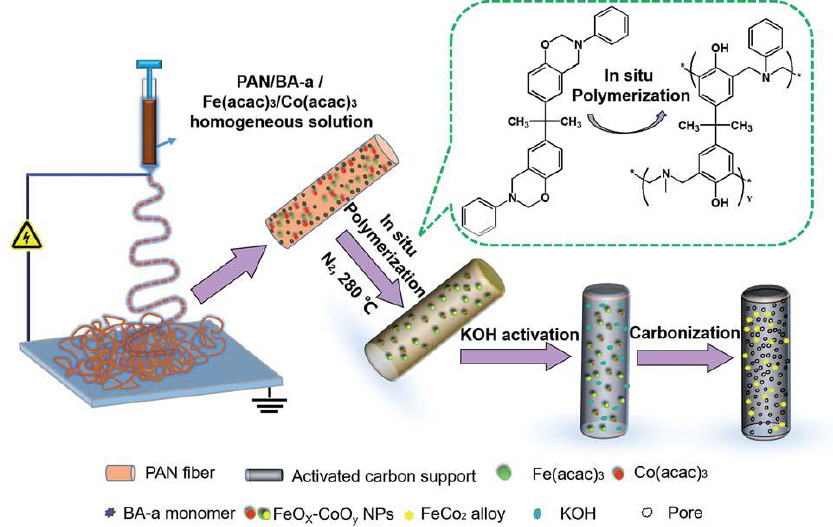
Figure 48. Synthesis scheme of FeCo 2 crystals supported on N-doped hierarchical structured porous carbon fibers (reproduced from the work in [62] with permission).